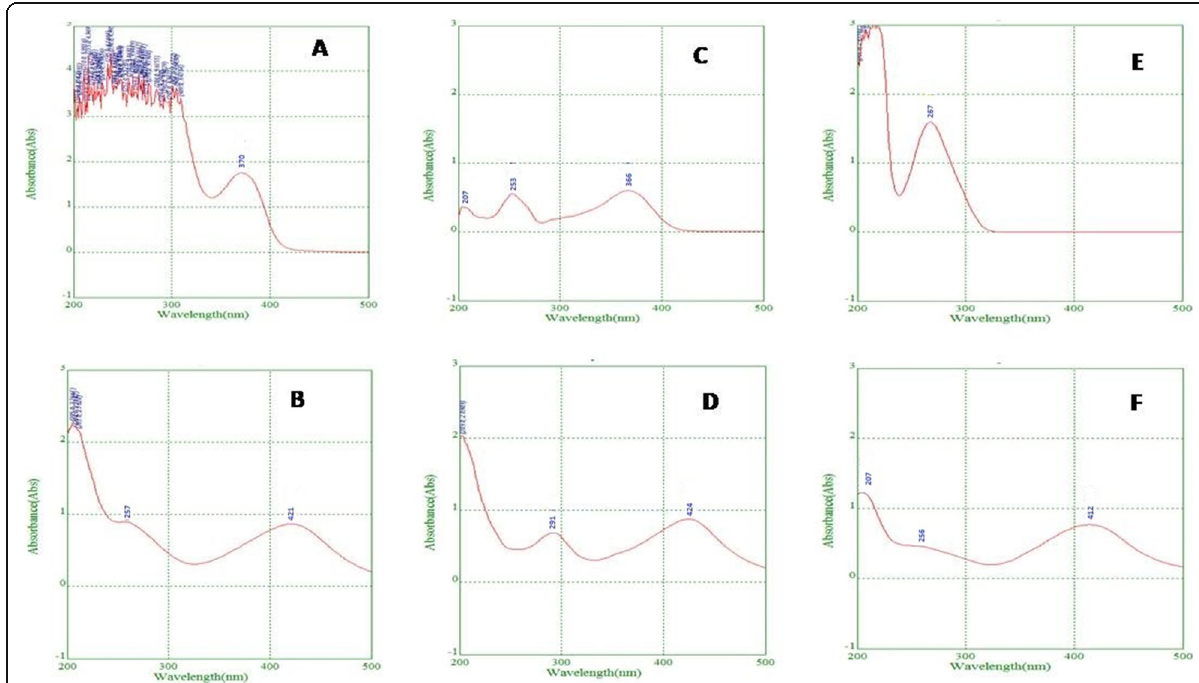
Fig. 2 a – f UV-Vis absorption spectra showing broad surface plasmon resonance peak of a PPE, b P-AgNPs, c quercetin, d Q-AgNPs, e gallic acid, and f